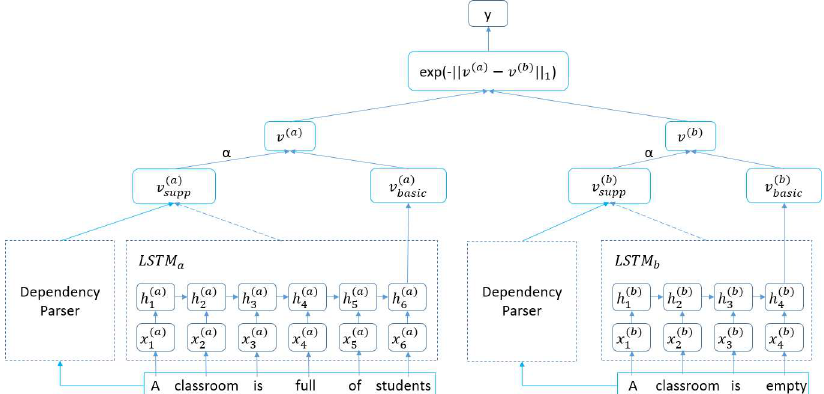
Fig 2. Dependency-based LSTM model. The D-LSTM uses a LSTM to read in word vectors and employs its final hidden state as a basic component v basic for each sentence. The D-LSTM performs a dependency parse on the input sentence and generates the supporting component v supp for each sentence. By introducing the weight factor α , the D-LSTM generates the sentence representation v according to v among these